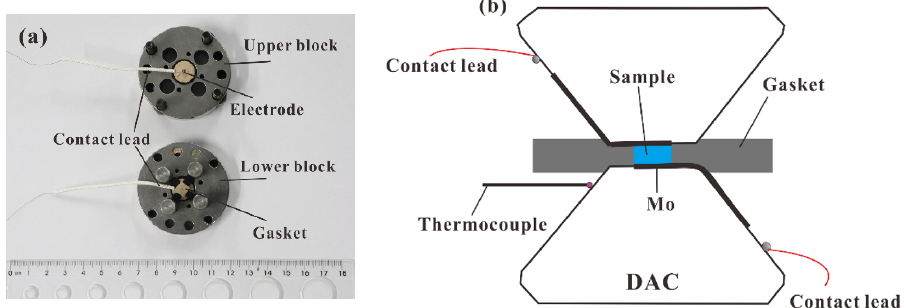
Figure 3. Measurement assemblage of sample for electrical conductivity measurements in the diamond anvil cell (DAC) at high pressure. In here, ( a ) stands for a detailed configuration for two symmetric plate electrodes integrated between upper and lower blocks of diamond anvils; ( b ) stands for the cross-sectional diagram of the DAC used for high-pressure impedance spectroscopy measurements.